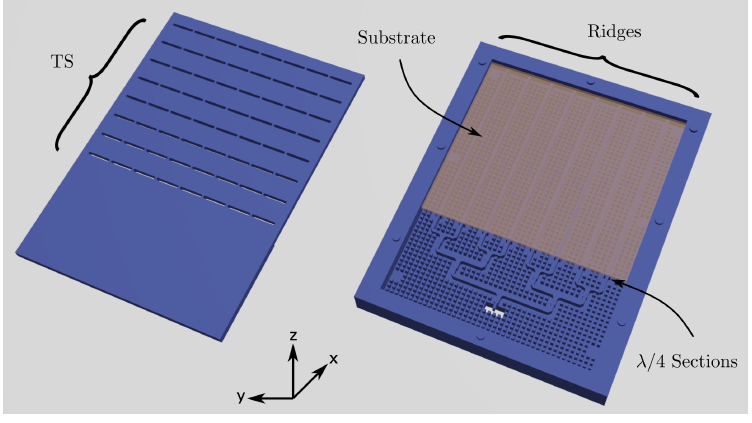
Figure 10. Schematic of the proposed antenna design. Table 2. Antenna